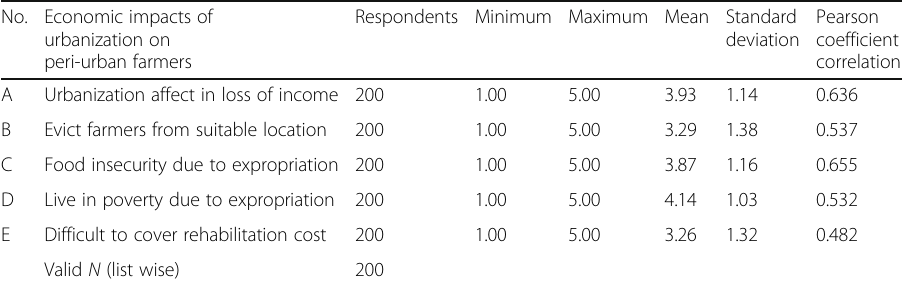
Table 6 The economic impacts of urbanization on livelihood of peri-urban farmers No. Economic impacts of urbanization